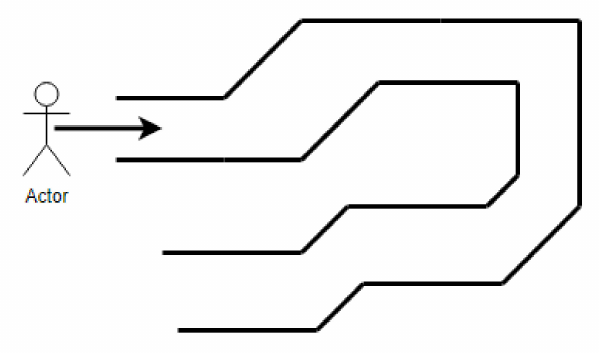
Figure 11. Testing the Obstacle mode on a sample pathway,